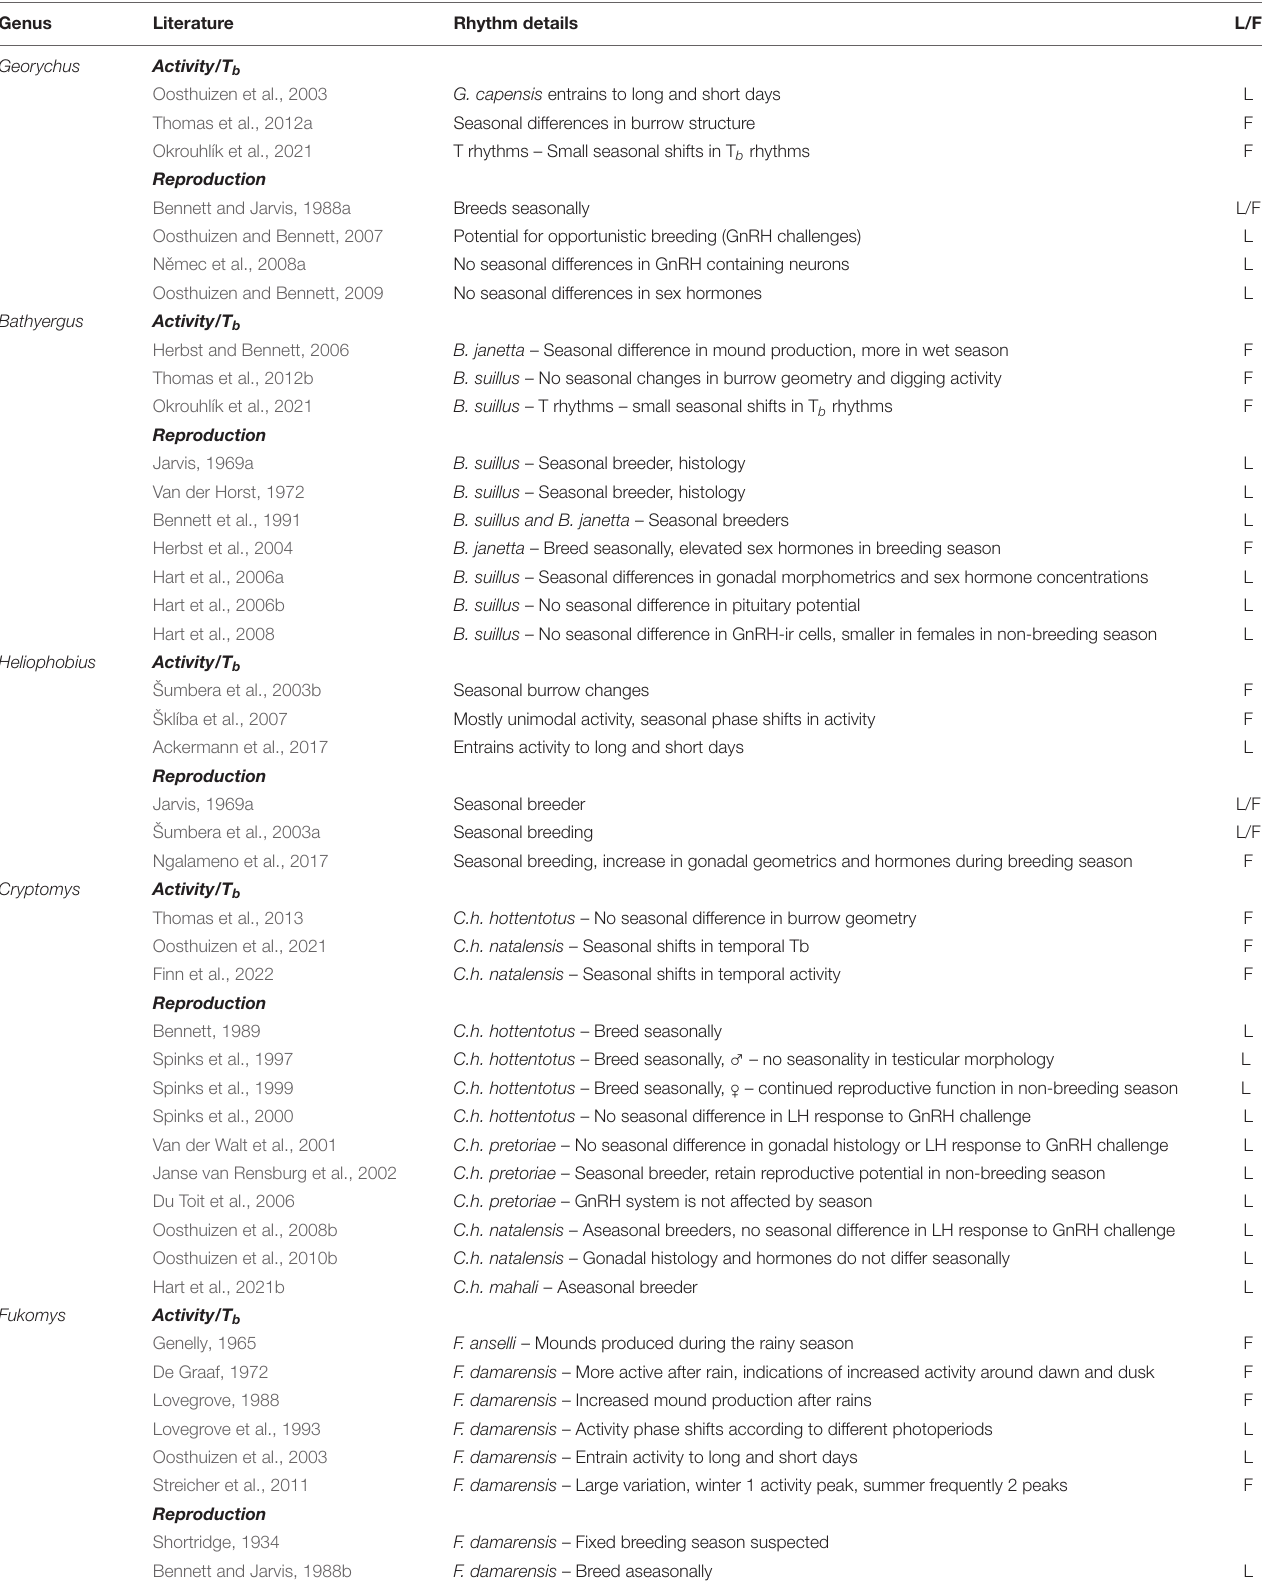
TABLE 2 | A summary of the literature on the presence or absence of seasonal rhythms in African mole-rats. Genus Literature Rhythm details